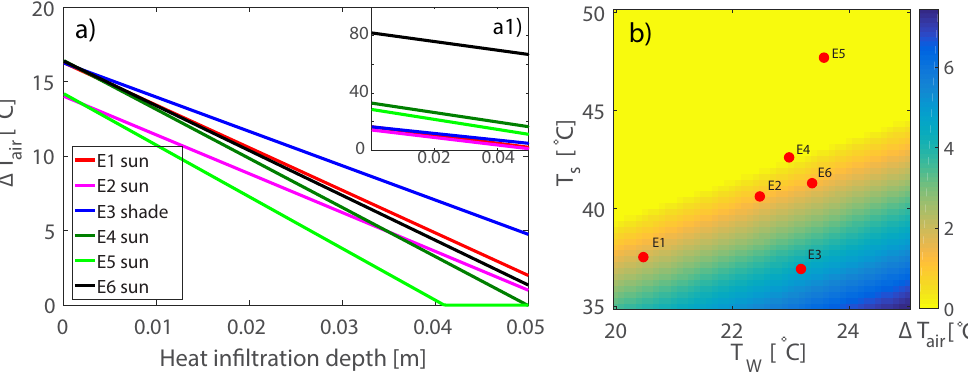
Figure 3. Analysis of influence of ( a ) heat-infiltration depth; and ( b ) wet bulb temperature ( T W ) and ground temperature before the beginning of the experiment ( T s ) on the cooling power of uchimizu ( ∆ T a ). Subplot ( a ) uses the measured values of T s , T W , and gust speed from the beginning of each experiment and 1 mm of water. Subplot ( a1 ) shows the same analysis with the actual amounts of water used in each experiment. Subplot ( b ) shows a prescribed gust speed of 2.41 m/s (average gust speed), 50 mm of heat infiltration depth, and applied amount of water of 1 mm. The red dots in subplot ( b ) show the combination of T s and T W for each